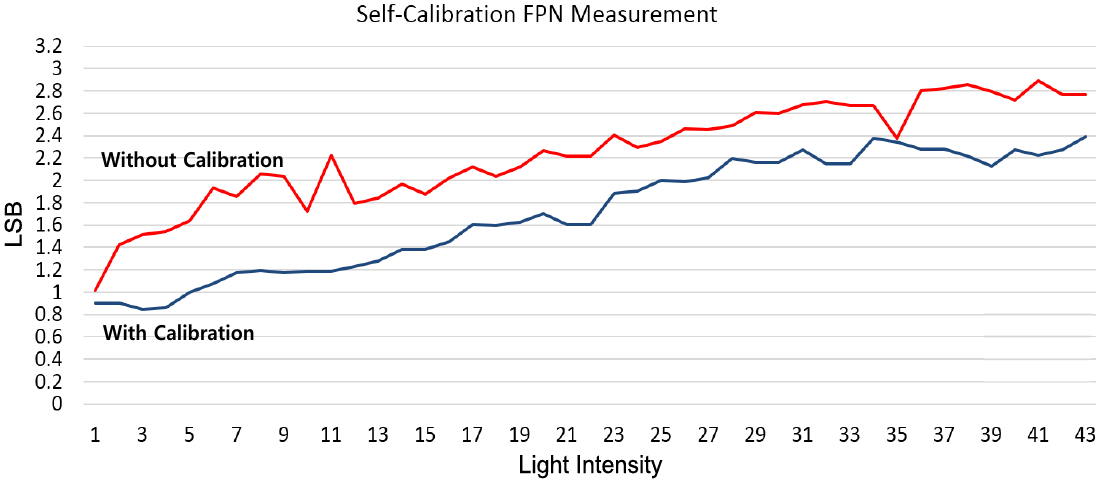
Figure 18. Measured CFPN with/without the self-calibration (10-bit